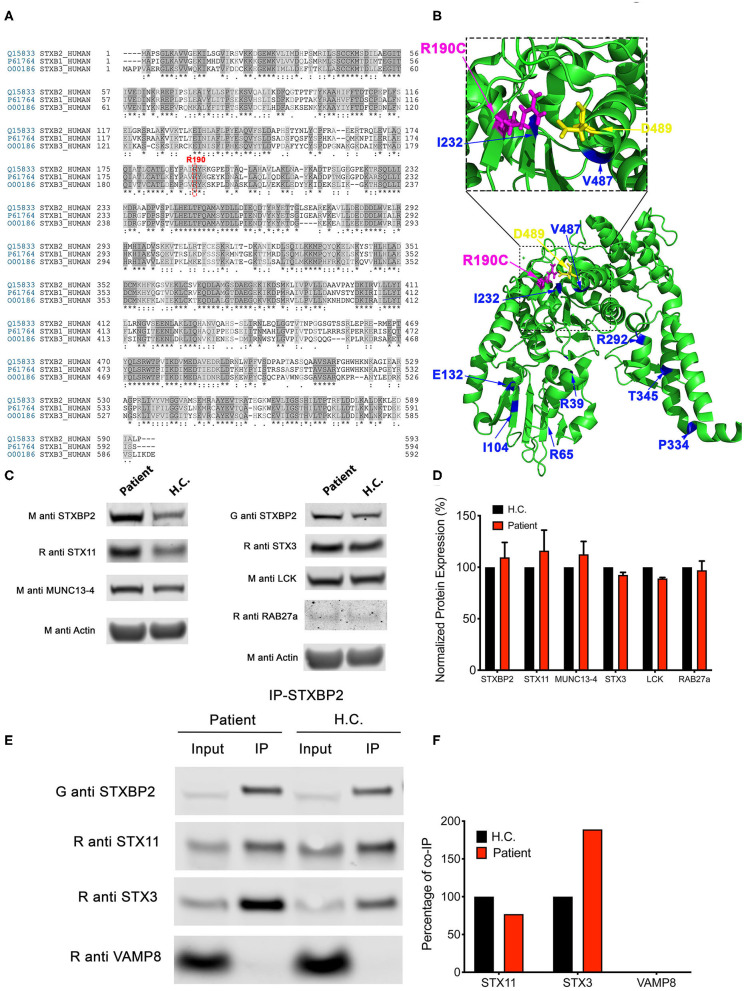
The STXBP2 mutation does not influence protein expression or the Munc18-2/STX11 interaction. (A) Alignment of human STXBP1/2/3 showing that arginine 190 reside is conserved among them. (B) Crystal structure of Munc18-2 (PDB:4CCA) with the R190 residue highlighted in magenta, residue D489, which makes electrostatic interaction with R190, in yellow and previously described f-HLH-5 mutations are shown in blue. (C) Western blots showing the expression levels of Munc18-2, STX11, STX3, MUNC13-4, RAB27a, and Lck in lysates prepared using PBMCs from H.C. and patient. Actin staining of the same membranes was used to assess for equivalent protein loading. (D) Bands in the Western blot that corresponded to Munc18-2, STX11, and MUNC13-4 were quantified by densitometry and normalized to the intensity of actin in the same lane. Densitometry results are expressed as the percentage of those obtained using control samples, which were set as 100%. Values represent the mean ± SD of two independent experiments. (E) Coimmunoprecipitation experiments using lysates generated from H.C. or patient PBMCs. Endogenous STXBP2 was immunoprecipitated using an anti–STXBP2 antibody, and the amount of STX11, STX3, and VAMP8 that coimmunoprecipitated was analyzed by Western blotting. (F) Bands in the Western blot that corresponded to the fraction of STX11, STX3, and VAMP8 that coprecipitated with STXBP2 were quantified by densitometry and normalized to the amount of STXBP2 immunoprecipitated in the same lane. Densitometry results were expressed as the percentage of those obtained in control samples, which were set as 100%.